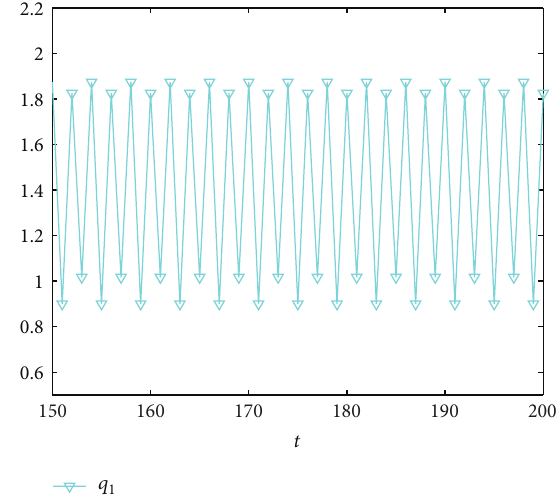
Figure 13: The wave plots of the output 𝑞 2 with the change of time when 𝛼 1 = 1.02 and 𝛼 2 = 1.46 , 𝜃 = 0.394 .